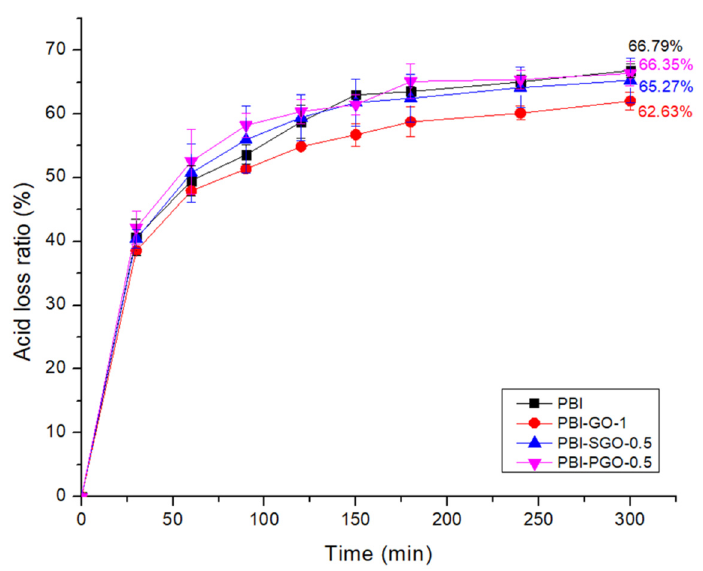
Figure 12. Phosphoric acid loss ratio of selected PBI composites.